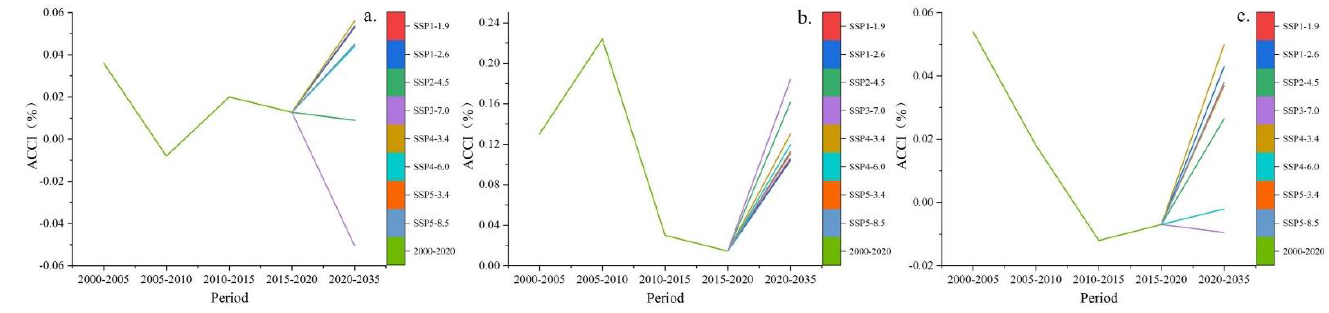
Figure 11. ACCI for Hubei ( a ), Hunan ( b ), and Jiangxi ( c ) Province, 2000 –